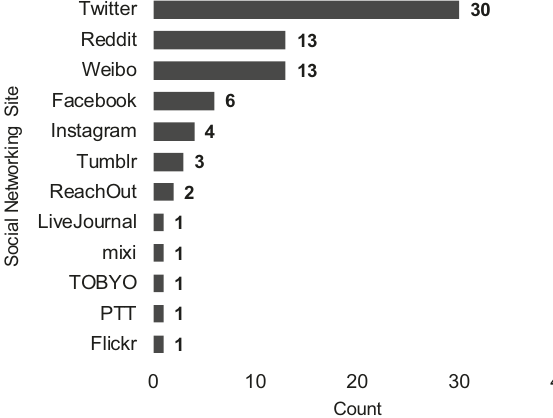
Fig. 2 Publication counts by social networking site. In this graph, we display the counts of publications, organized by the various social networking sites studied.